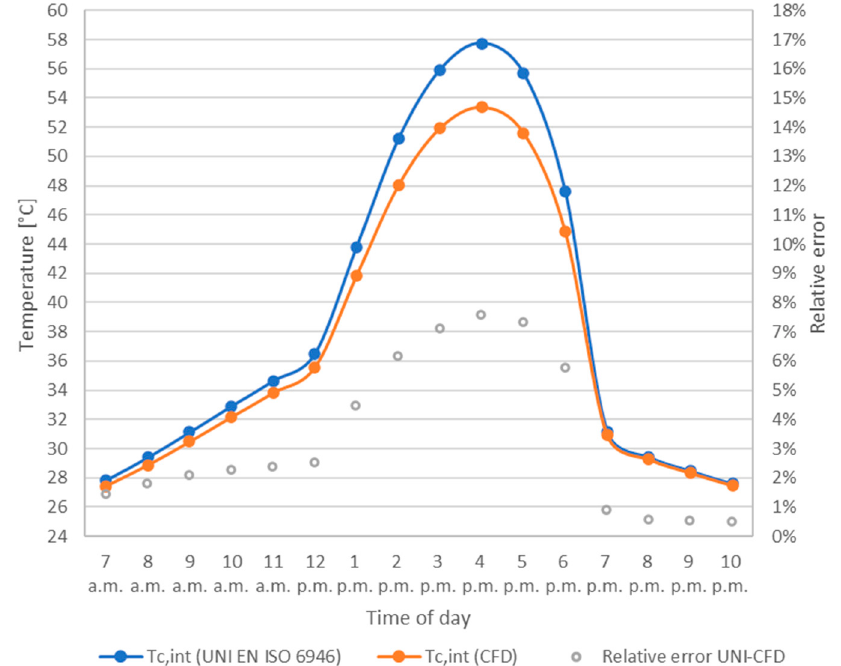
Figure 11. Comparison between the temperature values of the internal face of the cavity obtained by UNI EN ISO 6946 and by CFD. The graph shows also the RE of the CFD compared to the standard at each hour.